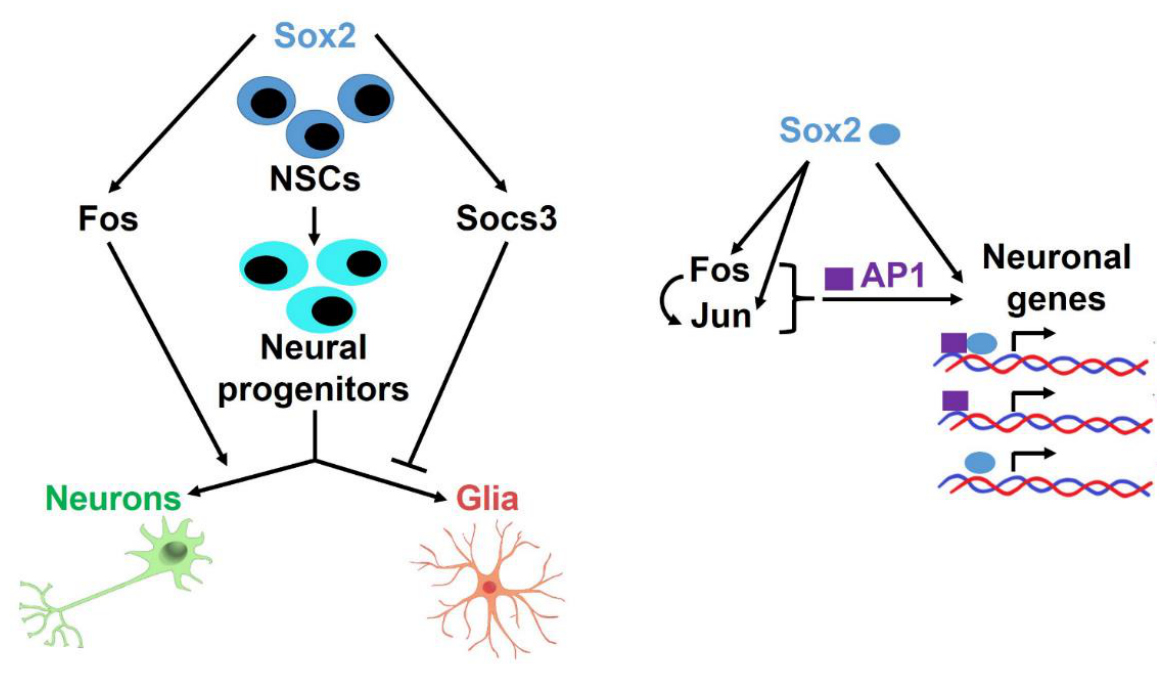
Figure 7. A simplified model for the roles of Sox2 , Fos , and Socs3 in NSC differentiation.